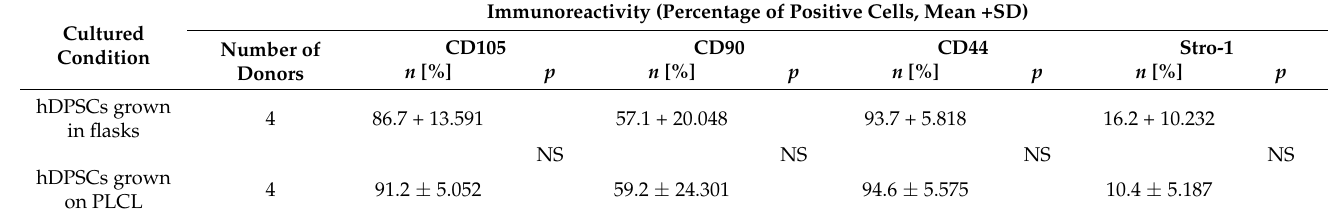
Table 4. Comparison of mesenchymal stem cell markers expression on hDPSCs growing onto PLCL scaffold and as a monolayer.